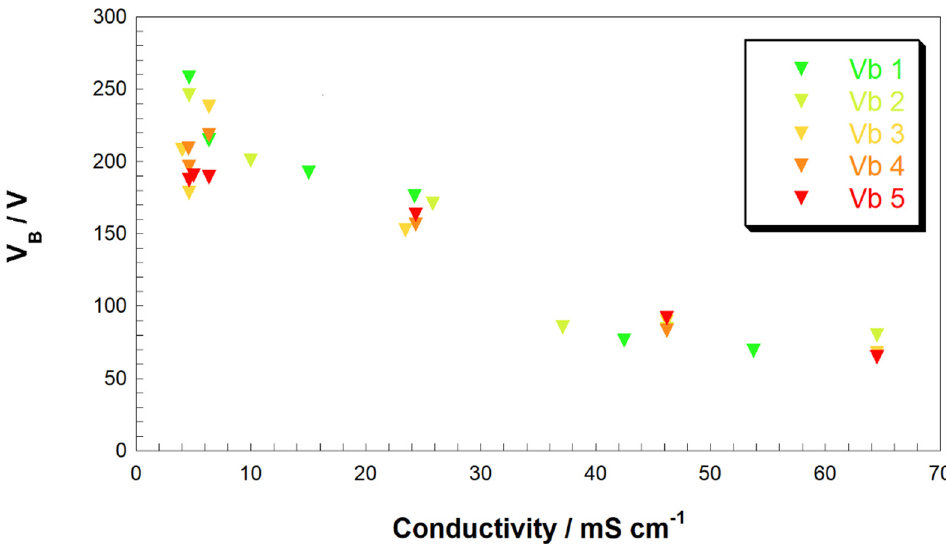
Figure 4. Breakdown voltage V B (V) vs. conductivity (mS/cm) with anode and cathode areas-ratio that equal to or higher than 1 (case of CGDE active anode). Electrolyte is the same for all experiments.